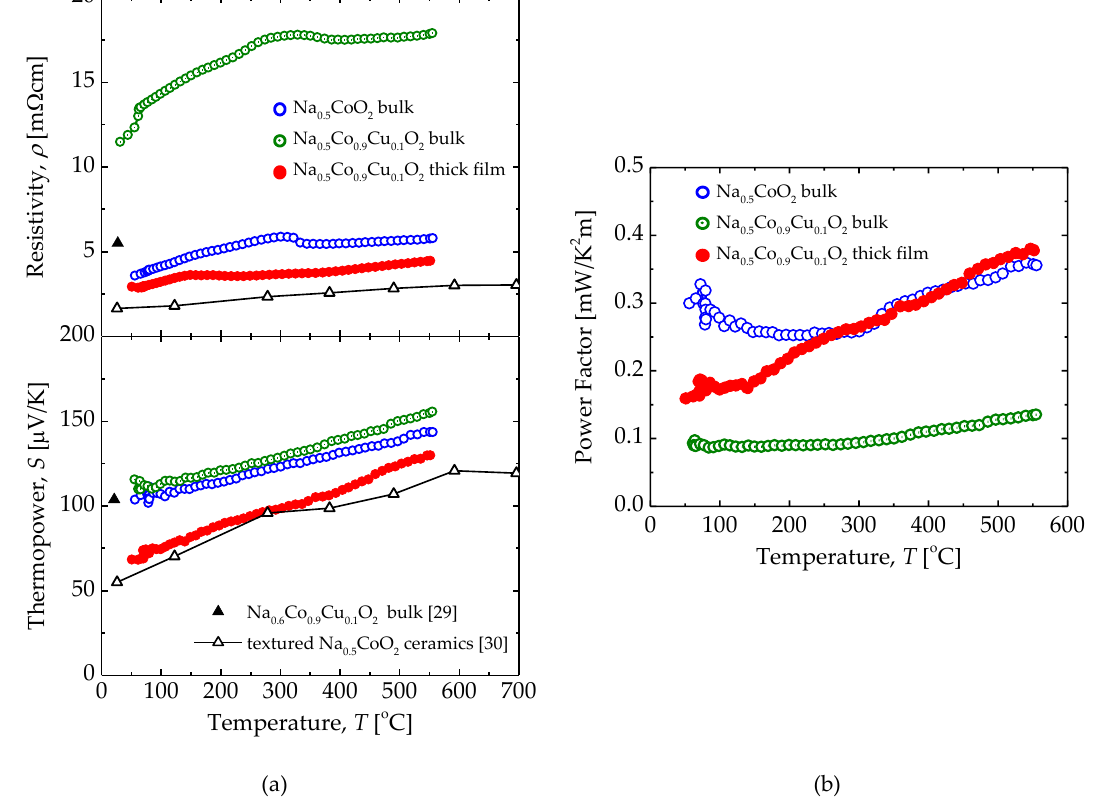
Figure 7. Temperature dependence of ( a ) resistivity, thermopower, and ( b ) power factor for a Na 0.5 CoO 2 bulk, a Na 0.5 Co 0.9 Cu 0.1 O 2 bulk, and the Na 0.5 Co 0.9 Cu 0.1 O 2 thick film measured in air.